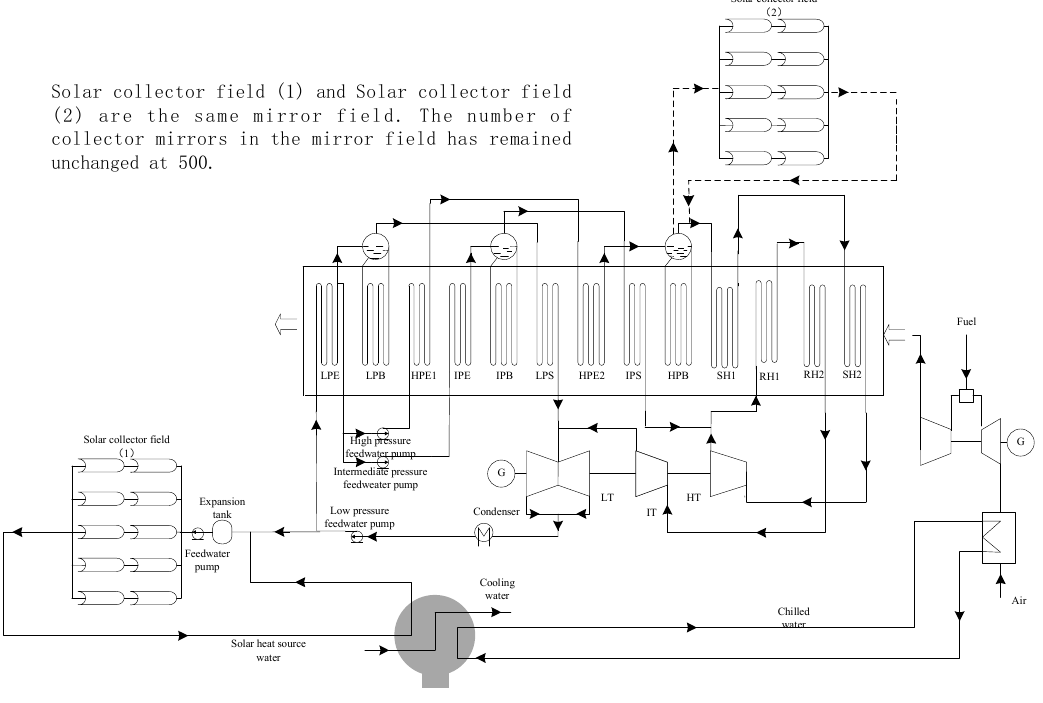
Figure 3. The flowchart of simultaneous integration solar energy into refrigerator and HRSG combined cycle.